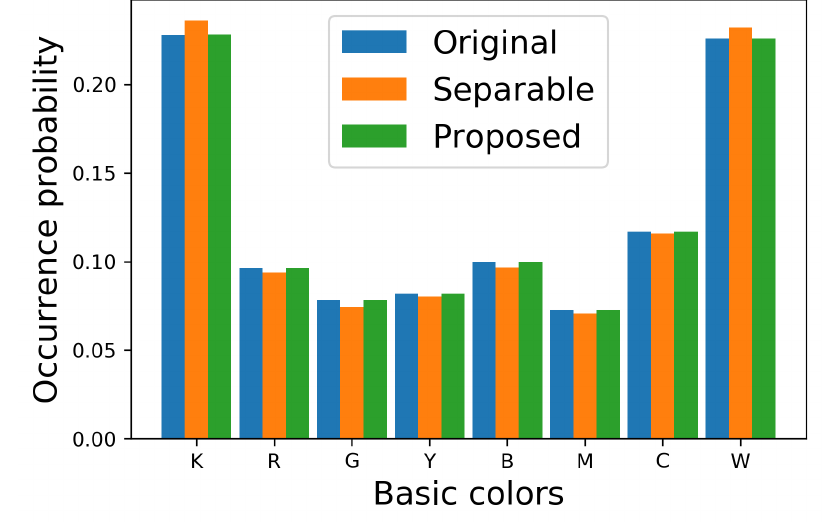
Figure 8. Occurrence probabilities of basic colors.